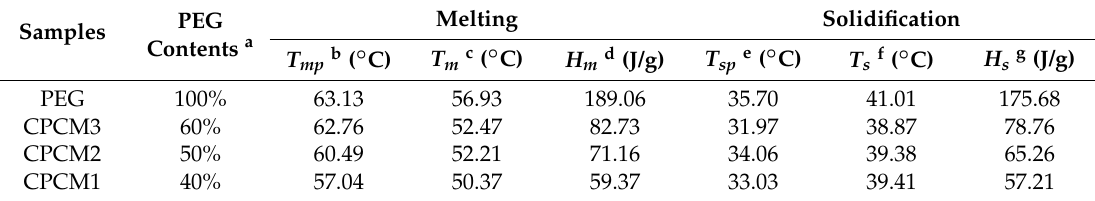
Figure 8. Differential scanning calorimetry (DSC) curves of PEG and CPCMs in different concentrations. Table 2. Phase change characteristics of CPCMs and